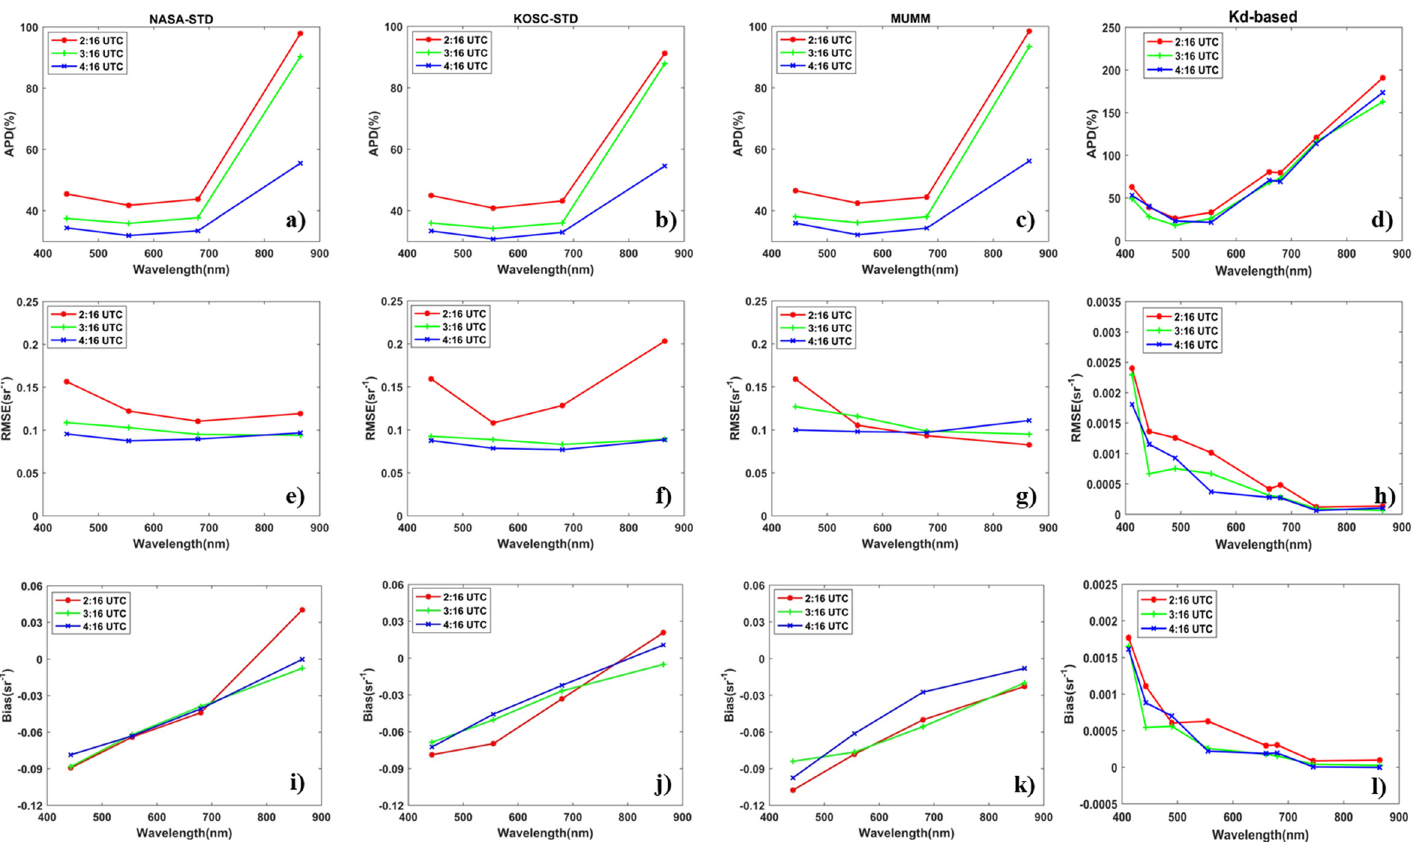
Figure 8. APD (%, upper row), RMSE (sr − 1 , middle row), and Bias (sr − 1 , lower row) of AOT per period (02:16, 03:16, and 04:16 UTC) and per algorithm (from left to right column: NASA-STD, KOSC-STD, MUMM, and Kd-based methods) as a function of wavelength. Symbols are the same as described in Figure 5. The four points on each line in each panel represent AOT at four wavelengths: 443, 555, 680, and 865 nm.